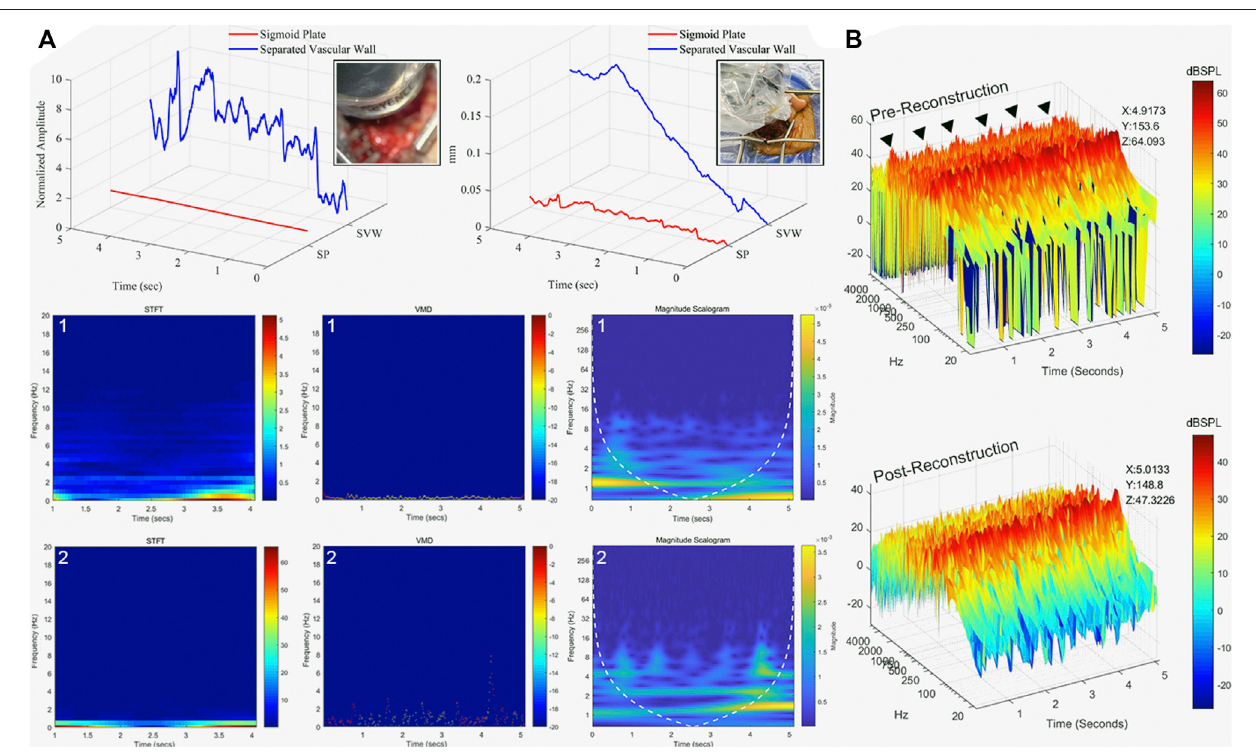
FIGURE 6 | Displacement and acoustic characteristics of sigmoid plate and PT. (A) Displacement characteristics of sigmoid plate and vascular wall after osseous andvascularwallseparationin fi vecontinuous seconds.(1)Thedisplacementmeasuredatthesigmoidplatebeforeseparationfromthevascularwall.Thedisplacement data presented in short-time Fourier transform (STFT), VMD, and the outcome of CWT (magnitude scalogram). (2) The displacement measured at the surface of the sigmoid sinus vascular wall. Observed pulse-synchronous signals marked with black triangles. The displacement data presented in STFT, VMD, and CWT. (B) Recorded acoustic signal of pre- and post-reconstruction of the sigmoid plate. The peak amplitude (z-axis, dB SPL) at speci fi c time (x-axis) and frequency (y-axis) is